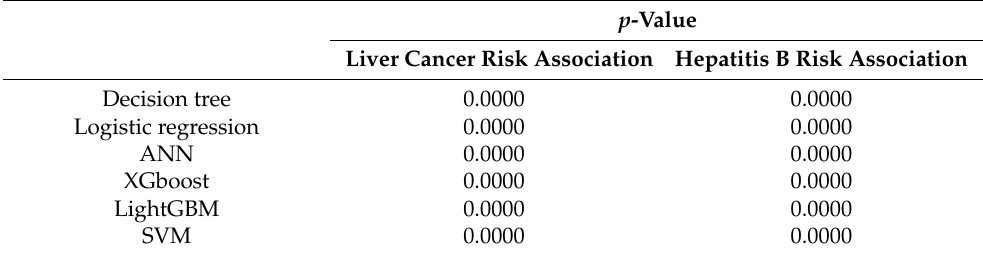
Table 18. Results of Wilcoxon signed-rank test between random forest and comparative models using 10% of the training dataset.